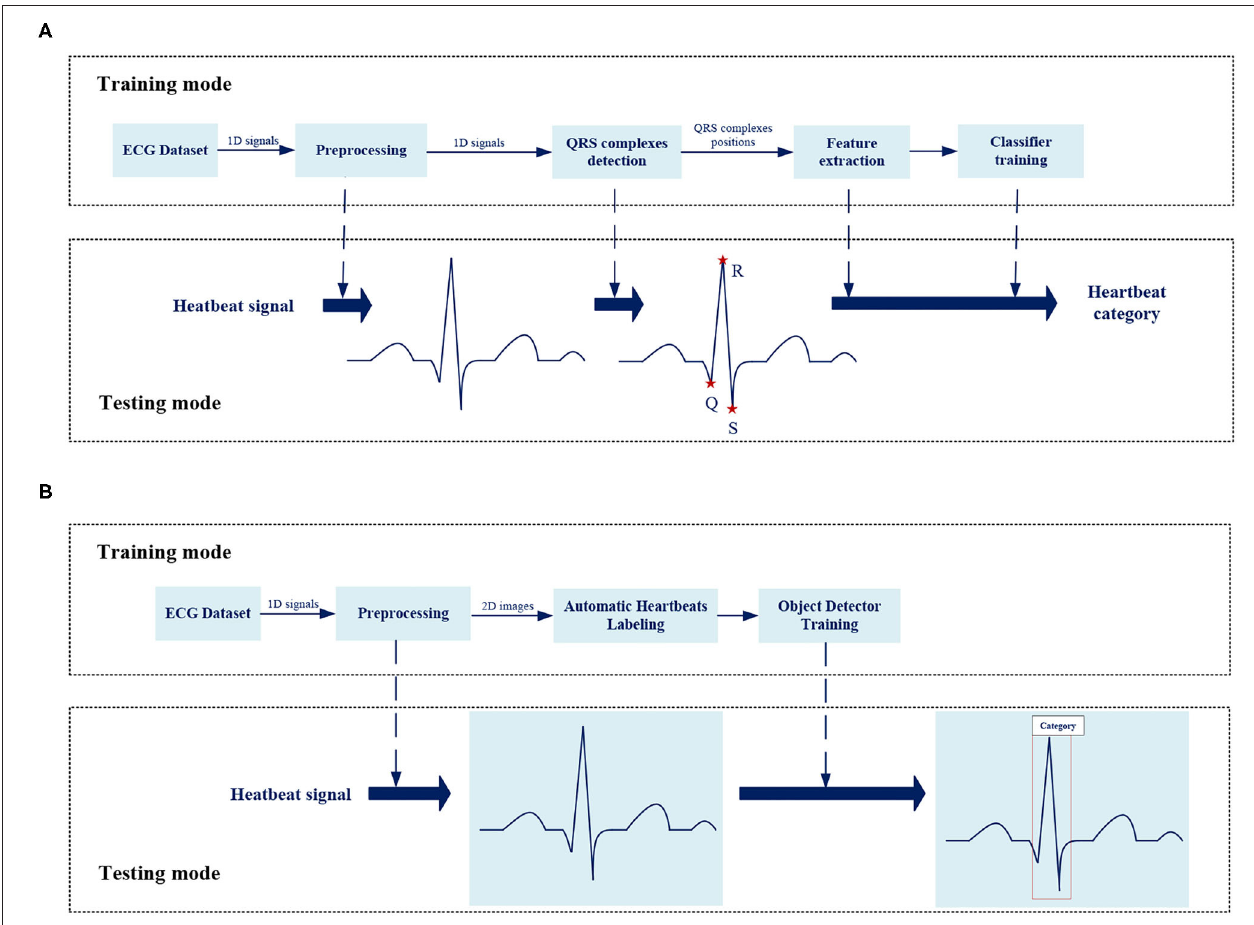
FIGURE 1 | The overview of the framework for analysis of ECG abnormality. (A) The framework of traditional method for ECG analysis. (B) The framework of proposed method for ECG analysis.